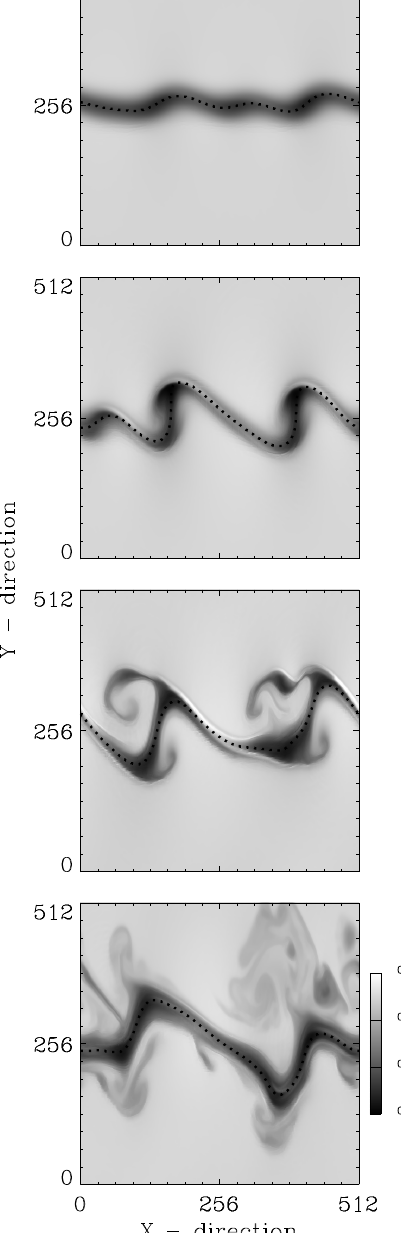
Fig. 2. Color-coded evolution of the magnetic pressure in the X − Y plane from top to bottom: at t = 10, t = 12, t = 14, and t = 19.